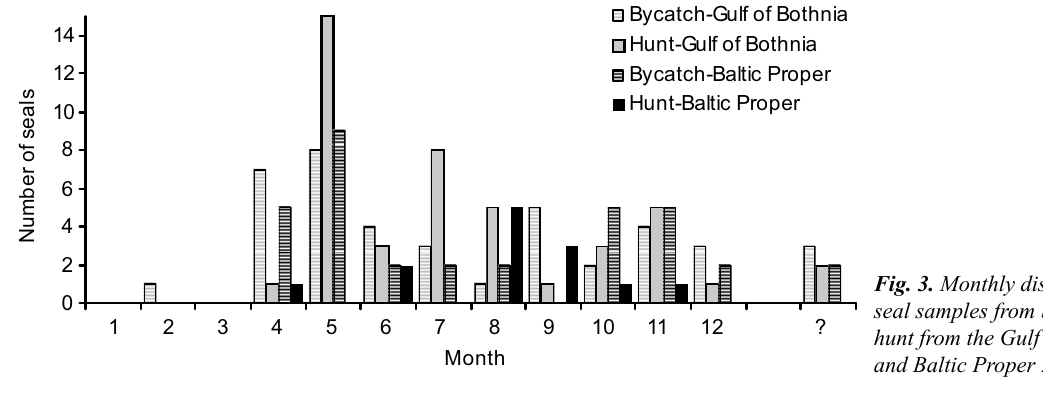
Fig. 3. Monthly distribution of seal samples from bycatch and hunt from the Gulf of Bothnia and Baltic Proper